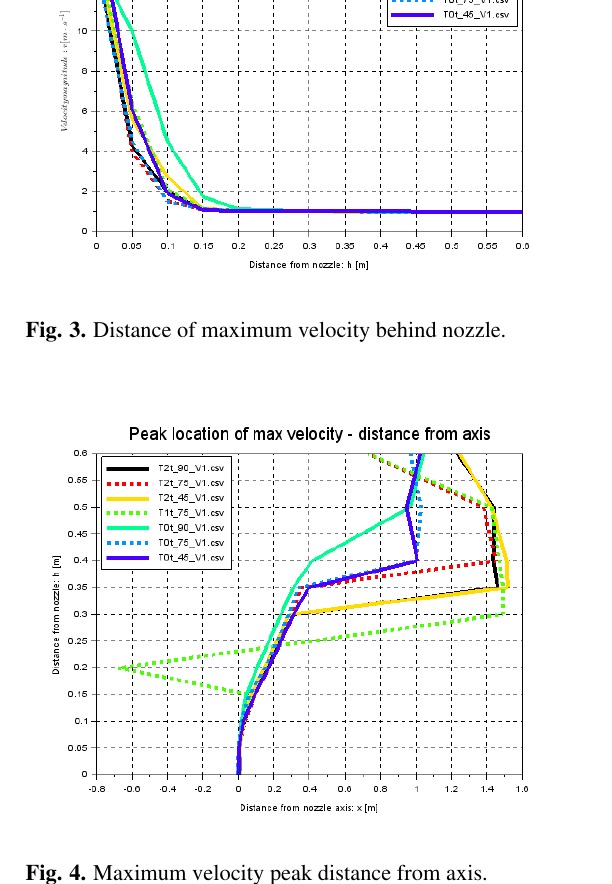
Fig. 4. Maximum velocity peak distance from axis .